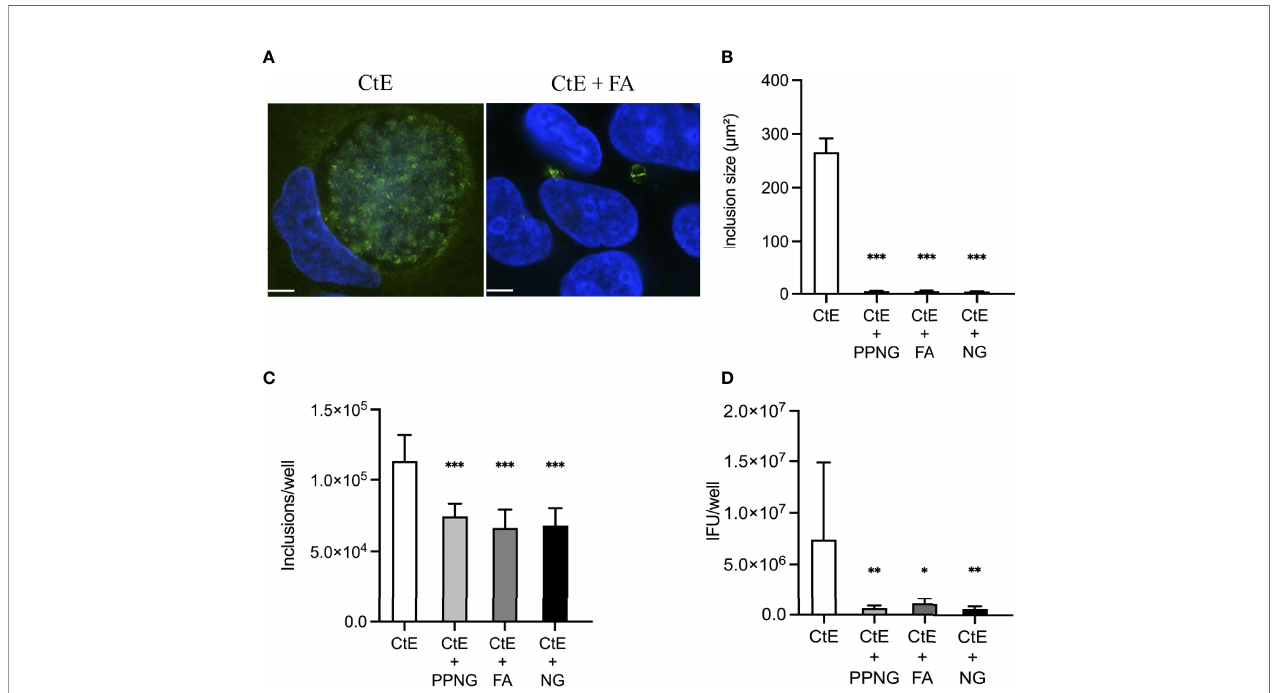
FIGURE 2 | Pre-infection of host cells with Ng limits CtE inclusion development and infectivity. HeLa cells were infected with Ng (minimum CFU inocula required for growth in culture medium) in cycloheximide-supplemented culture medium for 24 h prior to subsequent CtE infection ( Figure 1A ). Immediately after CtE infection, inocula were replaced with fresh cycloheximide-supplemented culture medium. Cycloheximide-supplemented culture medium was refreshed at 20 h post-CtE infection and samples were processed for IF analysis of inclusion formation/development or determination of infectivity (IFU/well) at 40 h post-CtE infection. Representative micrographs (A) of CtE (left) and CtE + FA (right) experimental groups, CtE inclusion size (B) (expressed as inclusion area, m m 2 ), CtE inclusions/well (C) , and CtE IFU/well (D) are shown. Scale bars = 5 µm; DAPI staining of DNA is indicated in blue and LPS immunolabeling of CtE is indicated in green. Signi fi cant differences from the control are indicated with asterisks: * p < 0.05, ** p < 0.01, *** p <